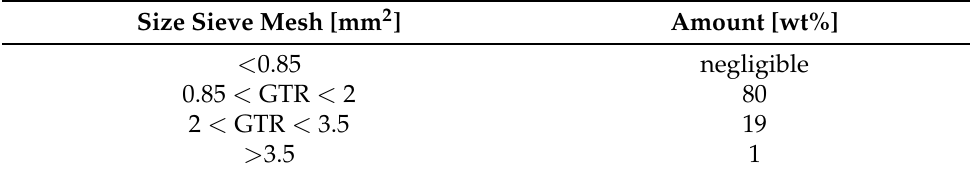
Table 2. Size distribution of the GTR after analysis with laboratory